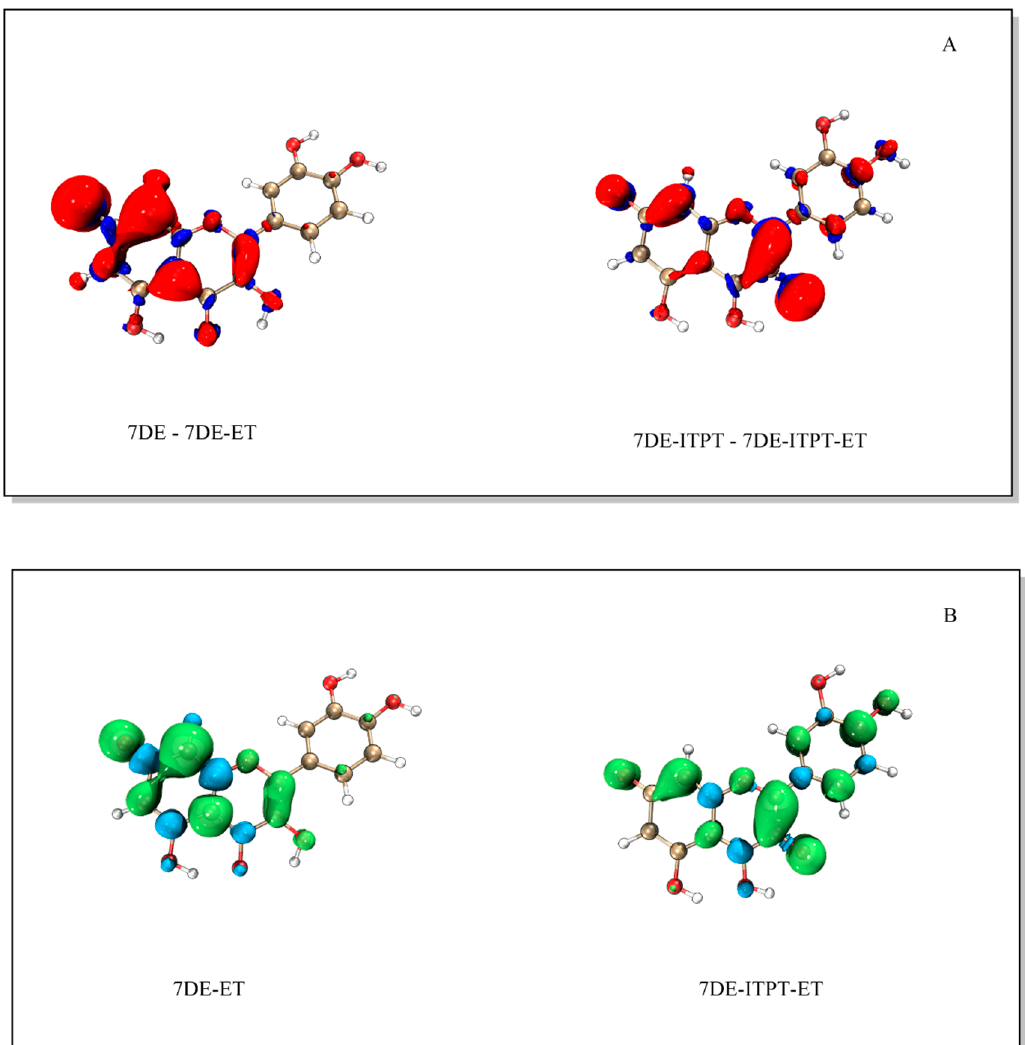
Figure 4. The electron density difference map of 7DE and of 7DE-ITPT with their corresponding radical (Panel ( A )), and the spin density of the 7DE-ET and the 7DE-ITPT-ET radical (Panel ( B )). In constructing the electron density difference map, the radical formed immediately after the electron transfer has taken place is used, and the electrons in the radical have not yet relaxed. The difference map shows where the electron is lost. The electron density map of the radicals depicted in panel B is of the stable radical.